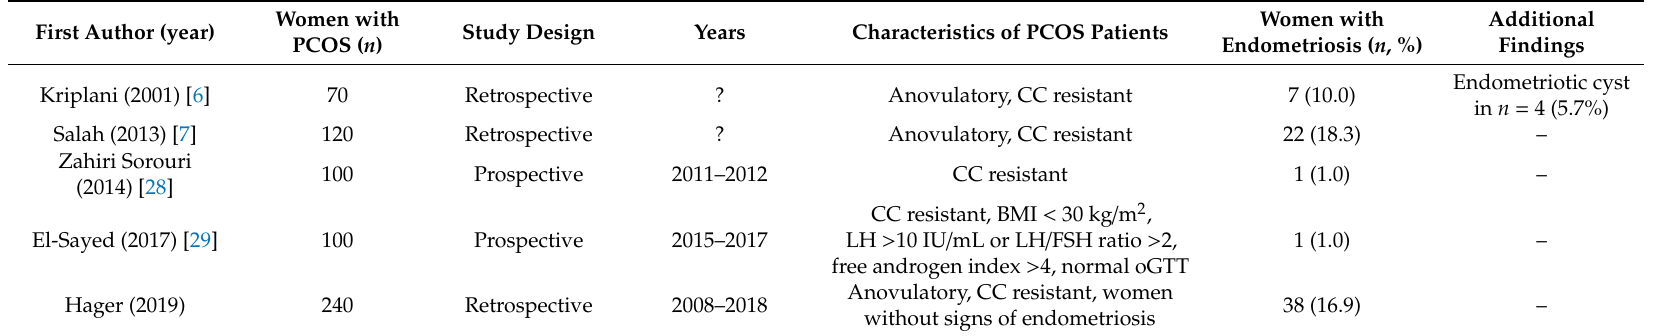
Table 1. Studies about endometriosis prevalence in women undergoing laparoscopic ovarian drilling included into the pooled analysis.